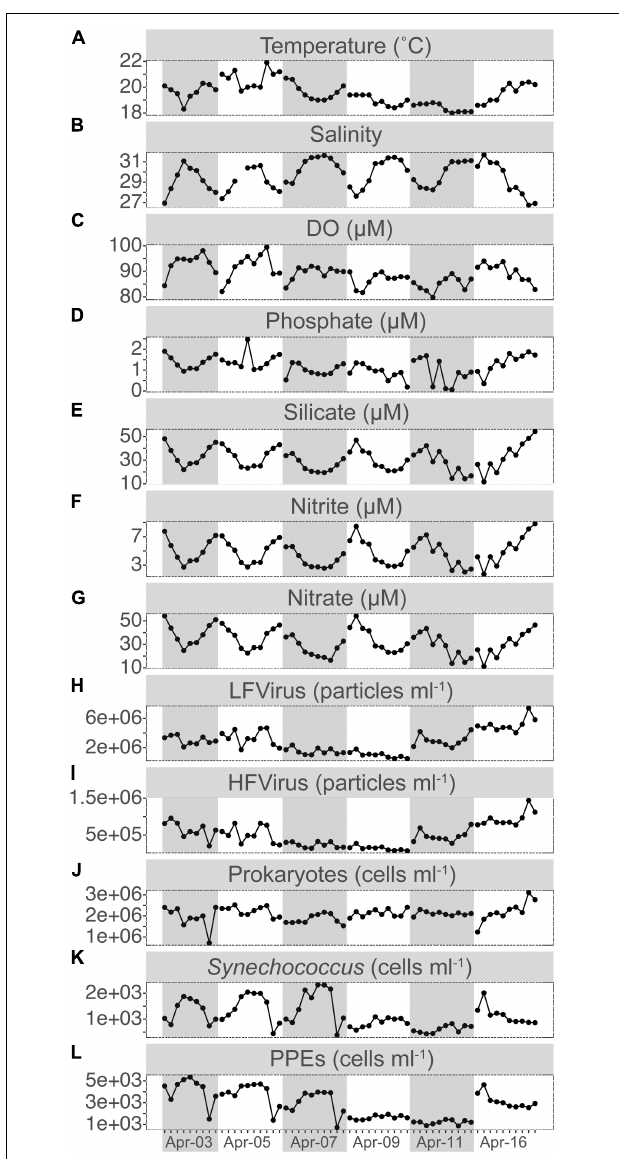
FIGURE 1 | Short-term time series of the dynamics for temperature (A) , salinity (B) , dissolved oxygen (DO, C ), phosphate (D) , silicate (E) , nitrite (F) , and nitrate (G) concentrations, LFvirus (low-fluorescence content virus, H ), HFvirus (high-fluorescence content virus, I ), heterotrophic prokaryotes (J) , Synechococcus (K) , and PPEs (pigmented picoeukaryotes, L ) abundance. Gray or non-gray shadow represented different sampling days.